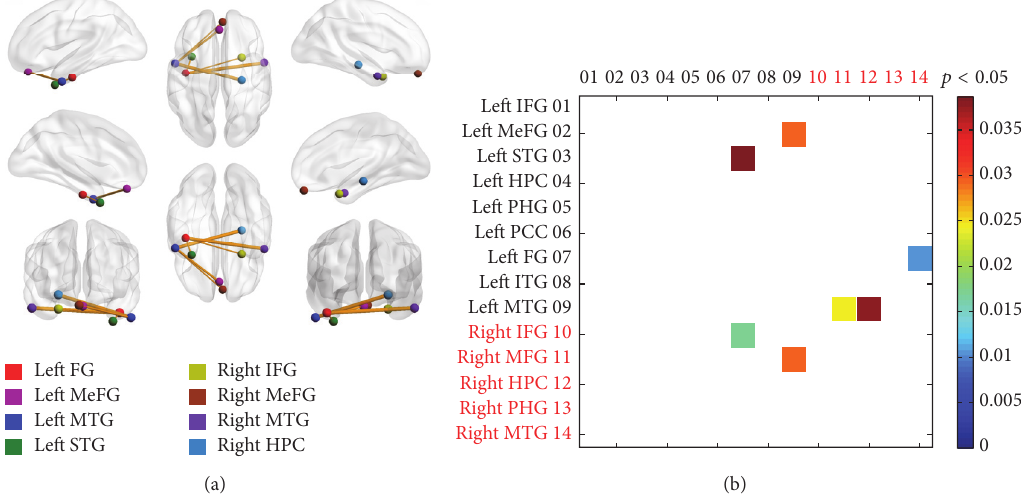
Figure 3: Changes of the driving effect in theepisodic memory network between mTBI and normal controls. (i) Most increased driving effects were detected between bilateral structures in patients surviving mTBI. (ii) No decreased causal interaction was found in mTBI survivors. (iii) Relative strengths of path weights (in arbitrary units) were indicated by the width of